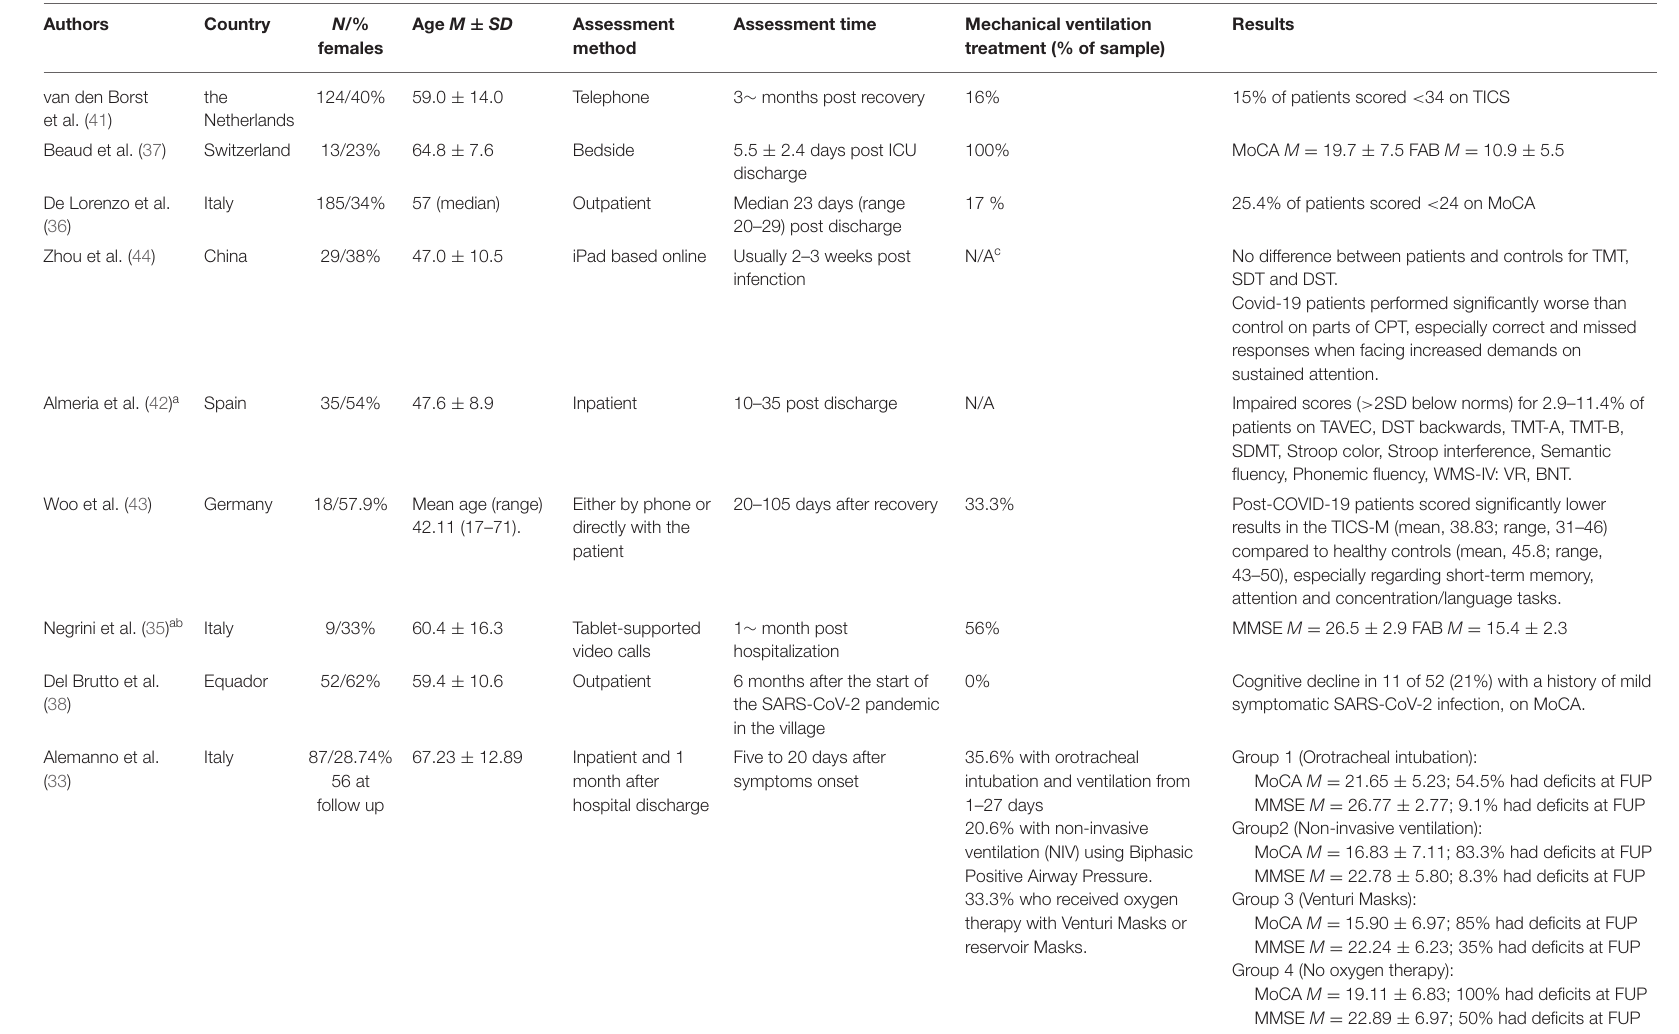
TABLE 1 | Overview of descriptive data and results for included studies on cognitive manifestations of